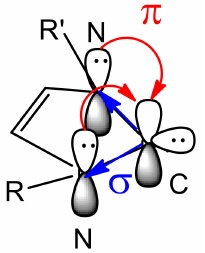
Figure 1. σ and π interactions between carbene and adjacent nitrogen atoms.